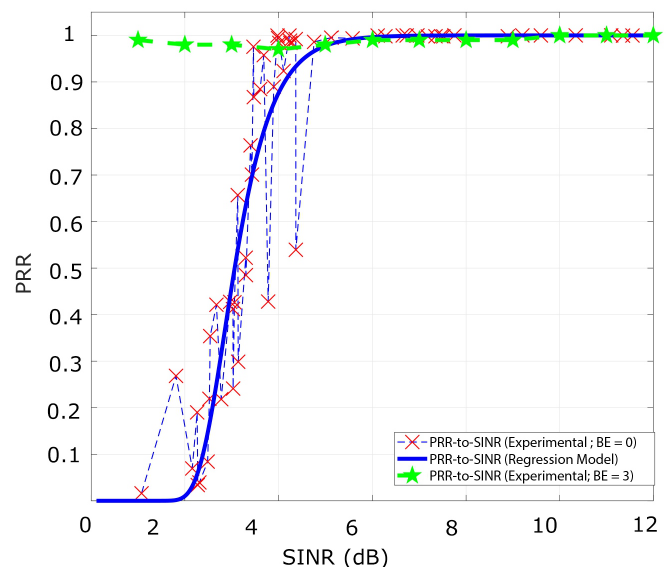
Figure 7. The PRR-to-SINR curve for BE = 0 and BE = 3 for one transmitter N c = 1 and one interferer N i = 1. The curve of the regression model is plotted to show a good agreement with the experimental results